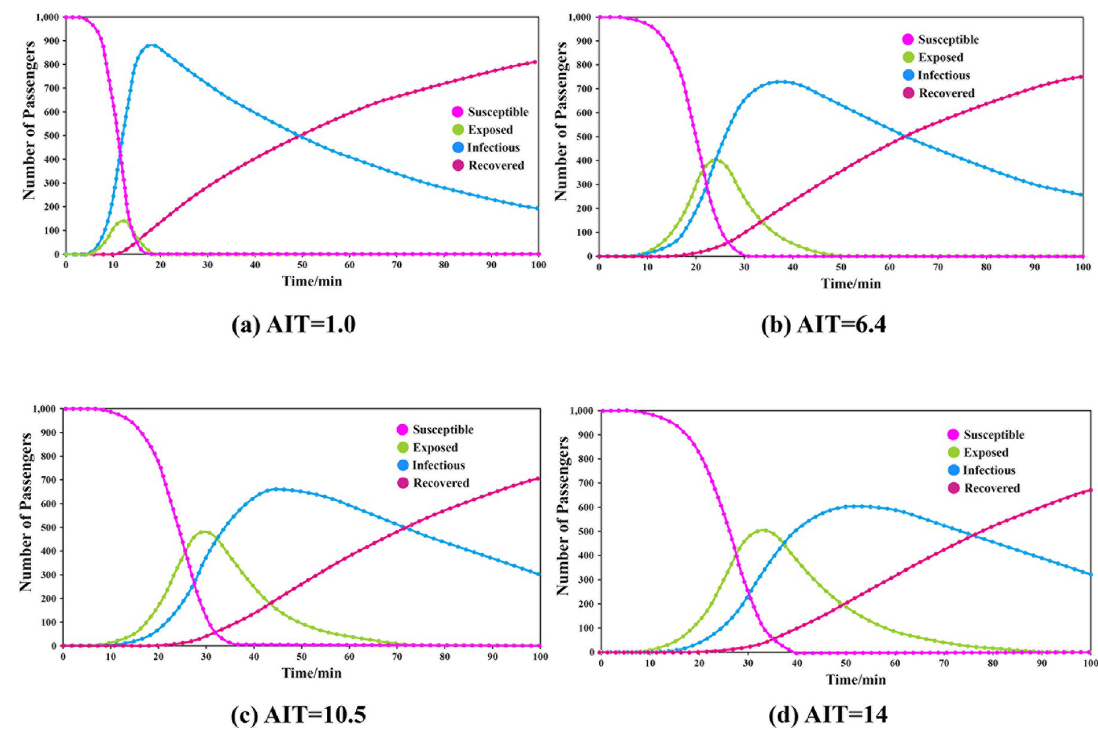
Fig 4. Results of different groups under different durations of exposure.